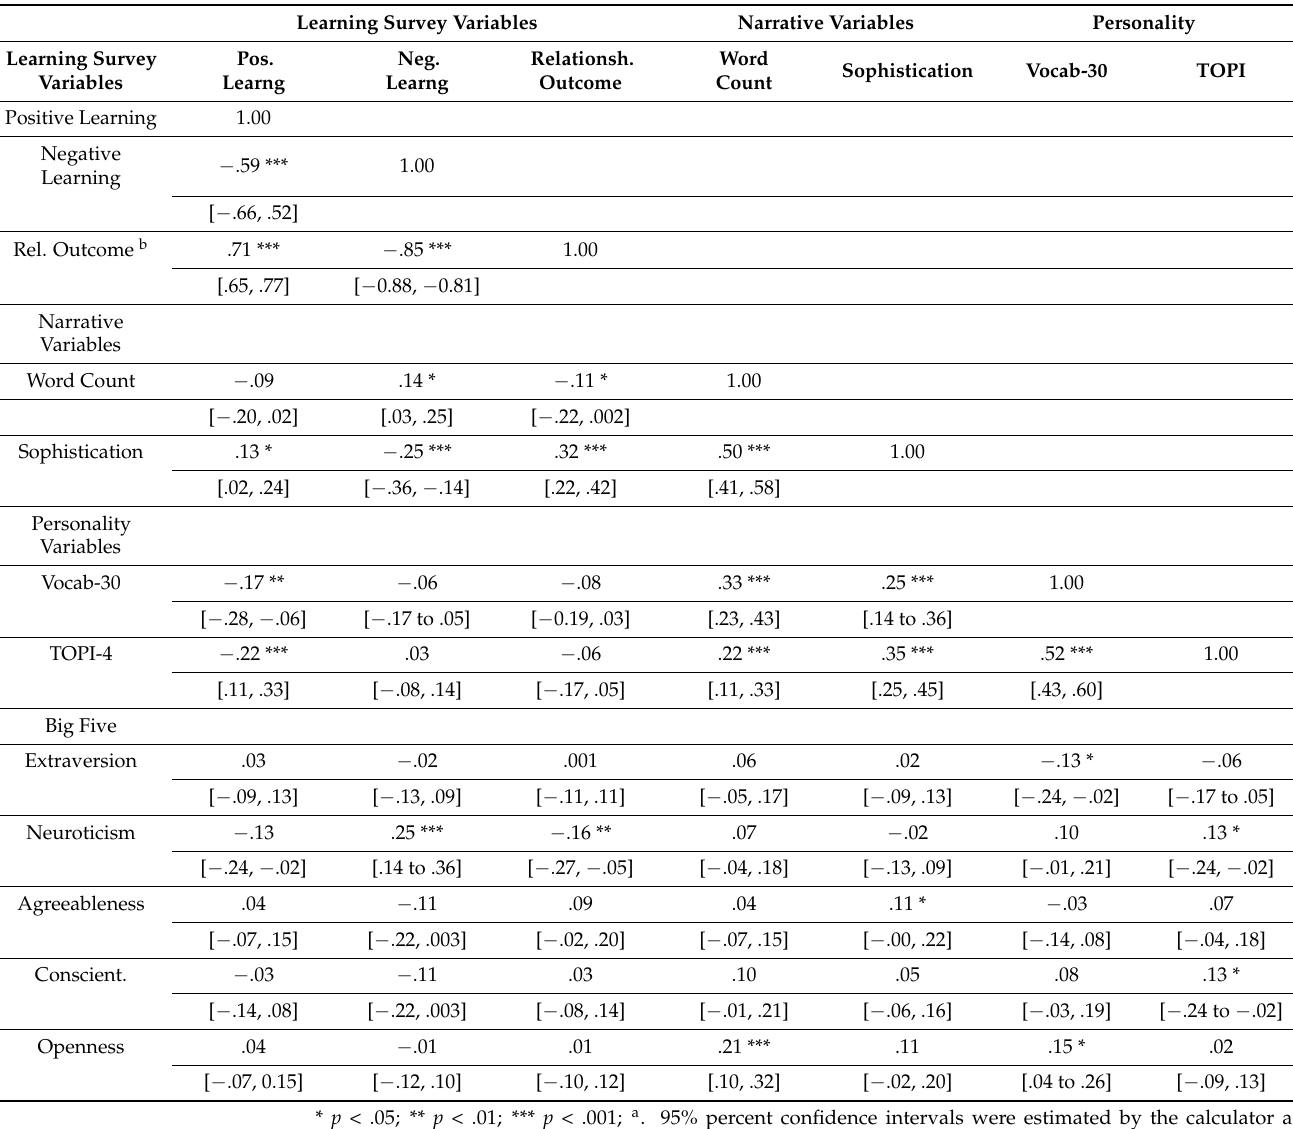
Table 5. Correlations and Confidence Intervals a Among the Key Variables of Study 2, N =